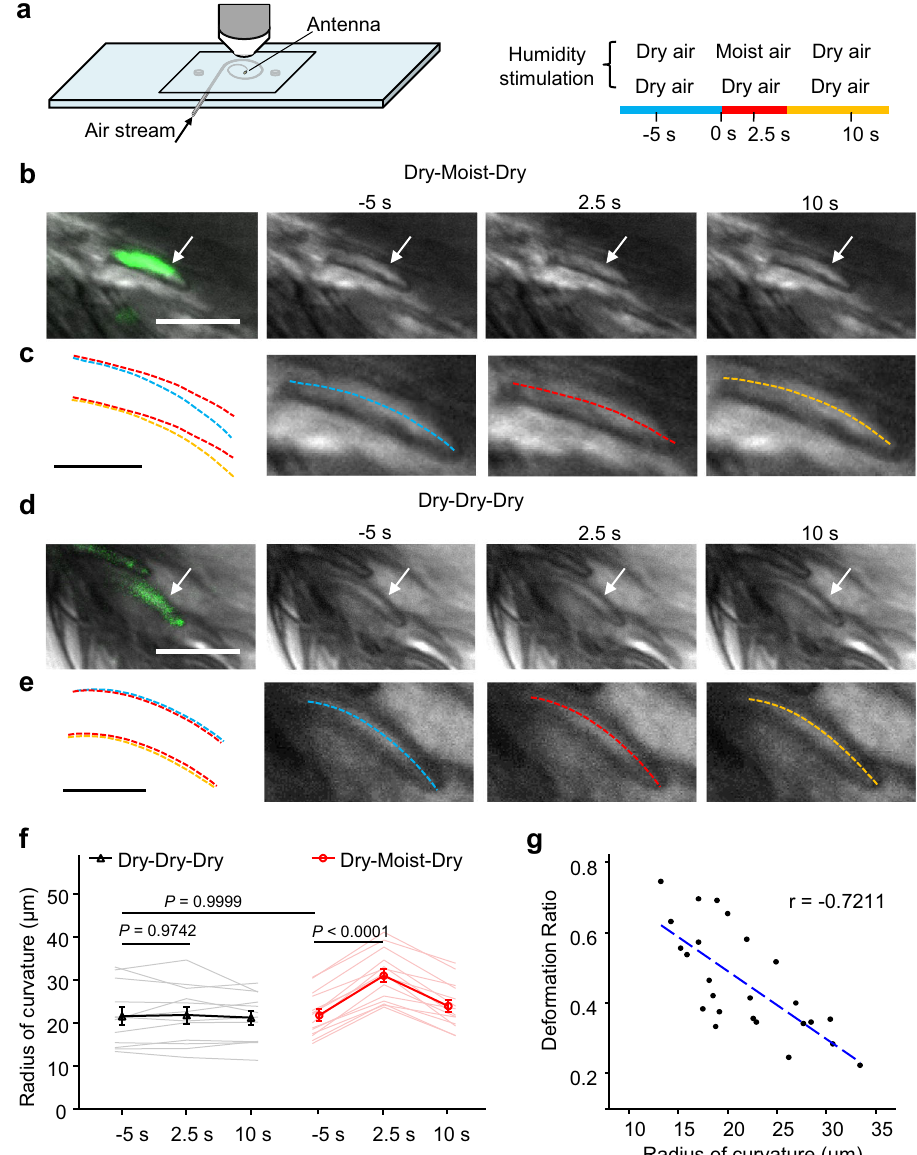
Fig. 2 The deformation of sensilla housing Or42b neurons upon humidity change. a Schematic depicting the experimental set up for sensilla imaging, the two humidity stimulations applied was indicated on the right. b Time-lapse images showing curvature changes of ab1 sensilla when challenged with sequentially applied dry-moist-dry air fl ows, the ab1 sensillum labeled by CD4-tdGFP is indicated by a white arrow. Scale bar, 10 μ m. c Zoomed in images of the GFP positive sensillum indicated in ( b ), dashed lines represent the curves fi tted to the shape of the sensillum. Scale bar, 5 μ m. d Images showing morphology of ab1 sensilla when challenged with switches of dry air fl ows without altering the humidity. Scale bar, 10 μ m. e Zoomed in images of the GFP positive sensillum indicated in ( d ). Scale bar, 5 μ m. b – e Representative images from over three independent replicated experiments. f Summary of curvature change of GFP positive sensilla under dry-dry-dry or dry-moist-dry air stimuli. n = 12 and 14 sensilla. Data are mean ± SEM., two-way ANOVA followed by Sidak ’ s post hoc test. Genotype of fl ies used for ( b – f ) was Or42b-Gal4 / UAS-CD4-tdGFP . g Scatter plot of deformation ratio (increase rate of radius of curvature) versus the initial radius of curvature for all 25 large basiconic sensilla (both GFP positive and GFP negative) that responded to moist air. n = 25 sensilla. Source data are provided as a Source Data fi